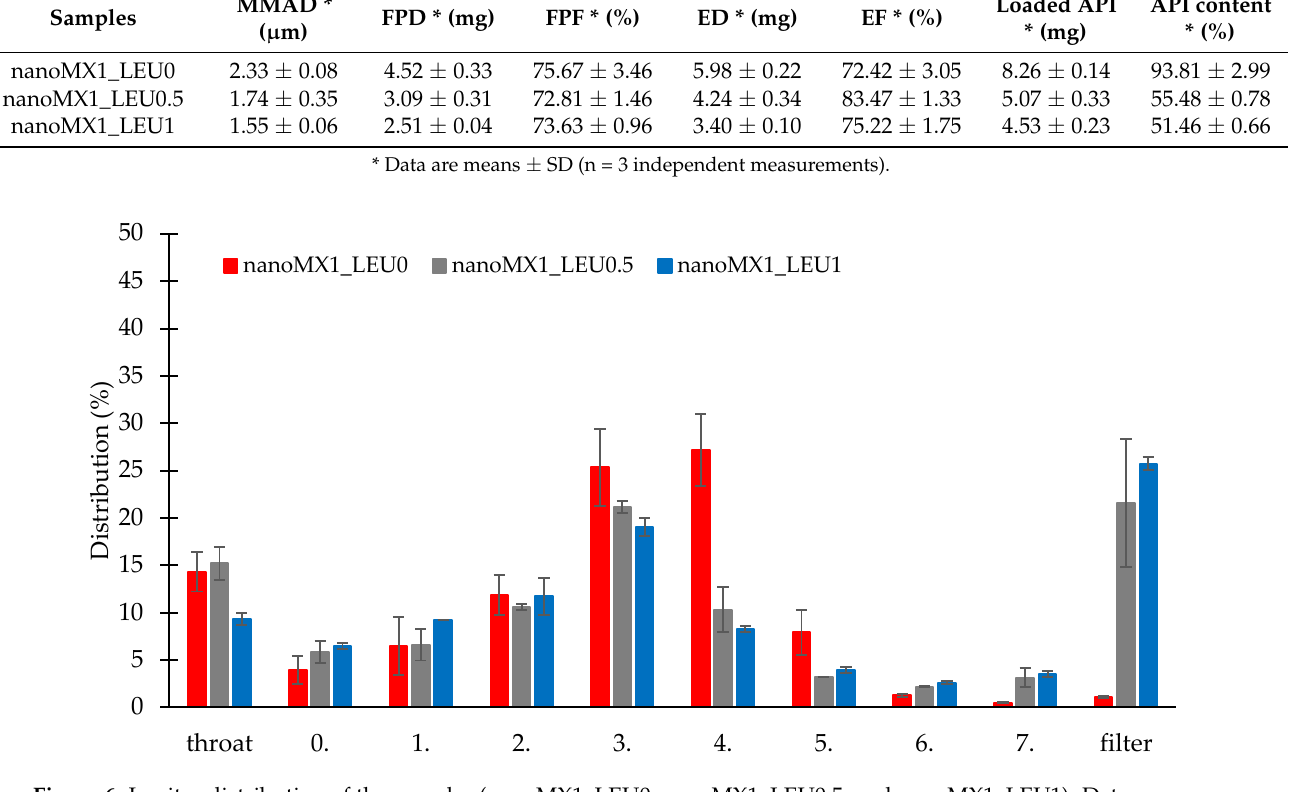
Figure 6. In vitro distribution of the samples (nanoMX1_LEU0, nanoMX1_LEU0.5, and nanoMX1_LEU1). Data are means ± SD (n = 3 independent measurements). Table 9. In vitro aerodynamic properties of the “nano-in-micro” systems. FPD, fine particle dose; FPF, fine particle frac- tion; ED, emitted dose; EF, emitted fraction.